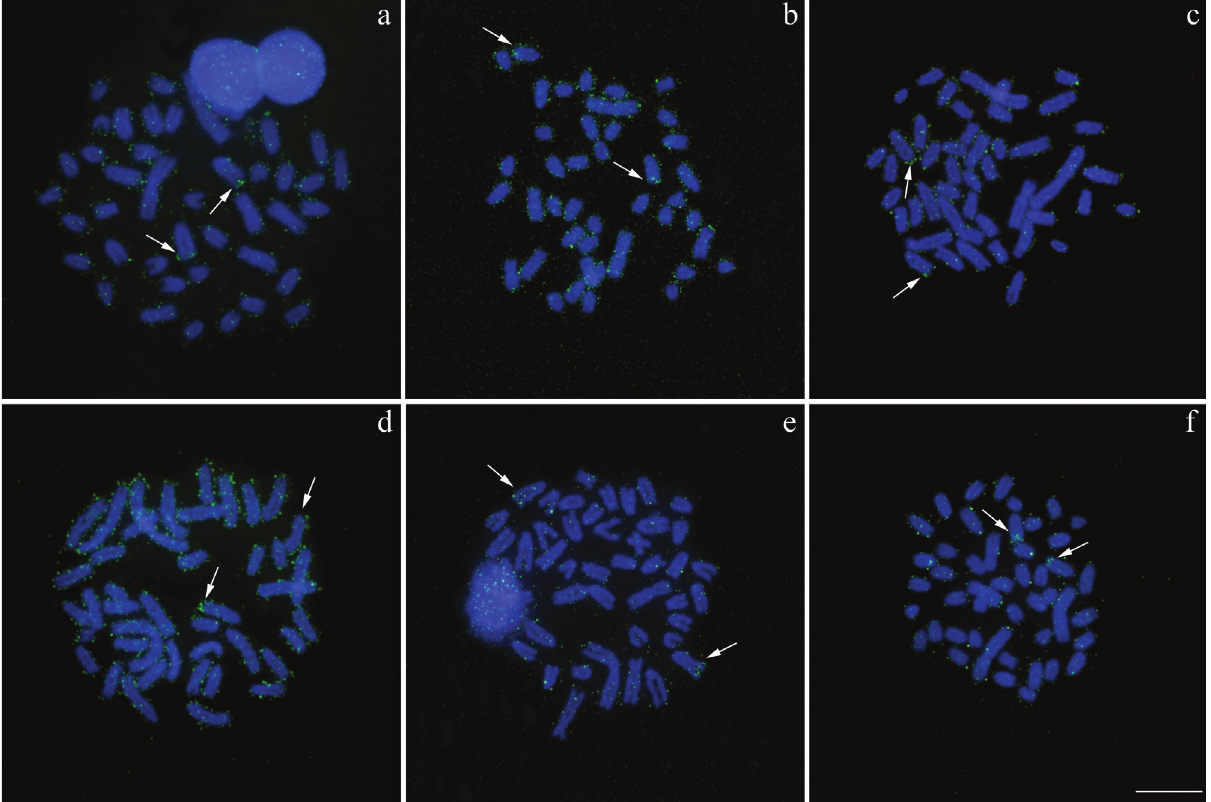
Figure2 -MetaphasesafterFISHtreatmentusingprobesofH3andH4histonesequences,respectively,inkaryomorphsA(a,d),B(b,e),andE(c,f).Ar- rows indicate the histone site clustering in the acrocentric pair. Bar = 10 (cid:2)